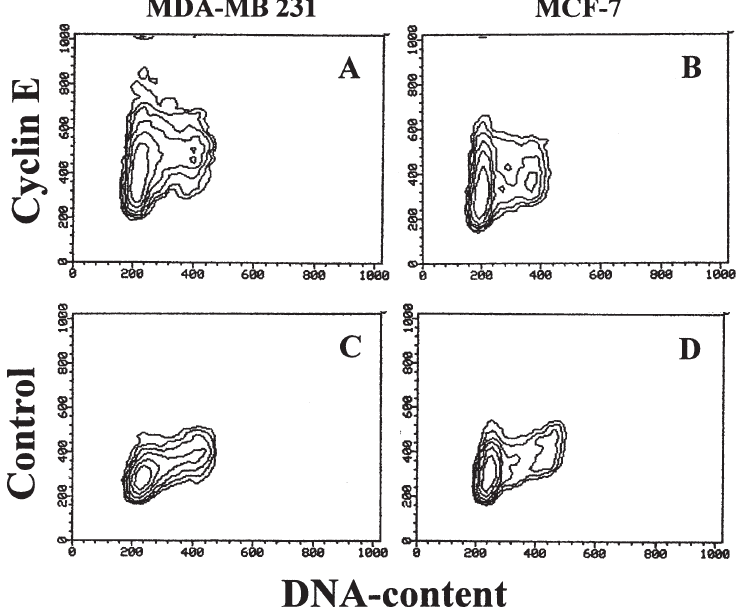
Fig. 1A. Flow cytometric analysis of cyclin E and DNA content (A, B) and control stainings (C, D) using two breast cancer cell lines, MDA-MB 231 and MCF-7.